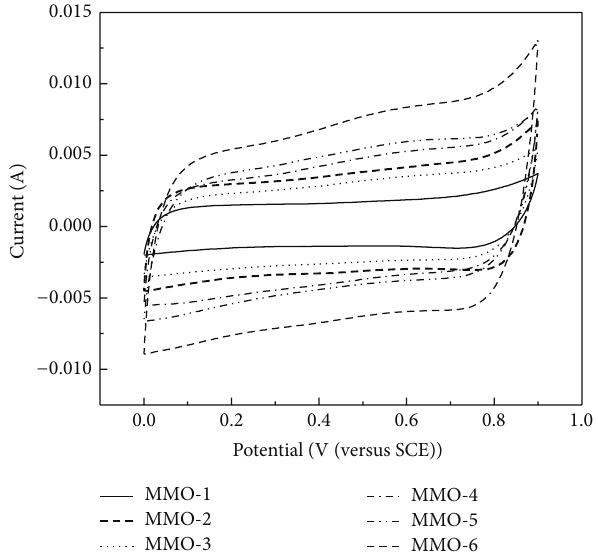
Figure 5: CVs of the samples of blank and MMO- 𝑥 ( 𝑥 = 1–6) at the scan rate of 5